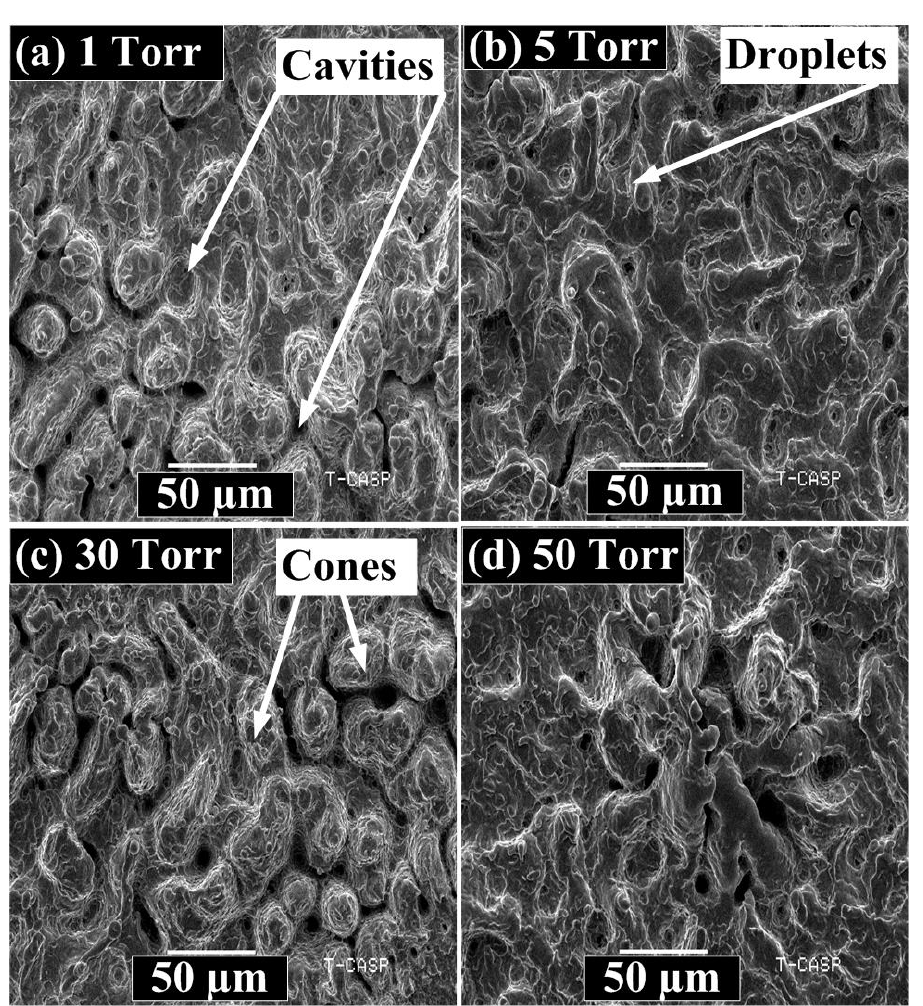
Figure 11. Surface morphological modifications in an Ar ambient environment at different pres- sures, ( a ) 1 torr, ( b ) 5 torr, ( c ) 30 torr, and ( d ) 50 torr, with a laser irradiation of 3.8 GW/cm 2 in the TMF.